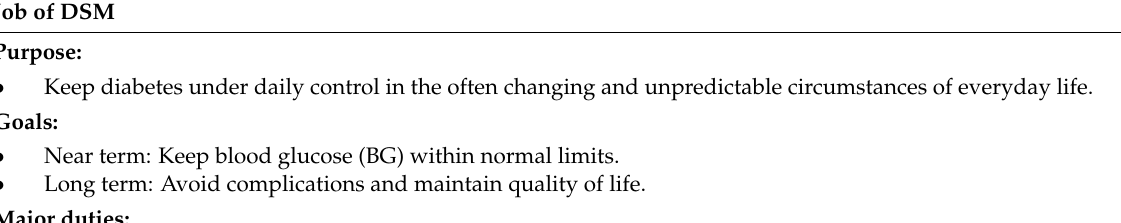
Table 3. The higher-order cognitive processing required for optimal diabetes self-management (DSM). (From “Safe-Guarding Cognitive Access to Diabetes Self-Management as Abilities Decline with Age” by Gottfredson and Stroh 2021, pp. 9–11. Copyright 2021 by Canadian Diabetes